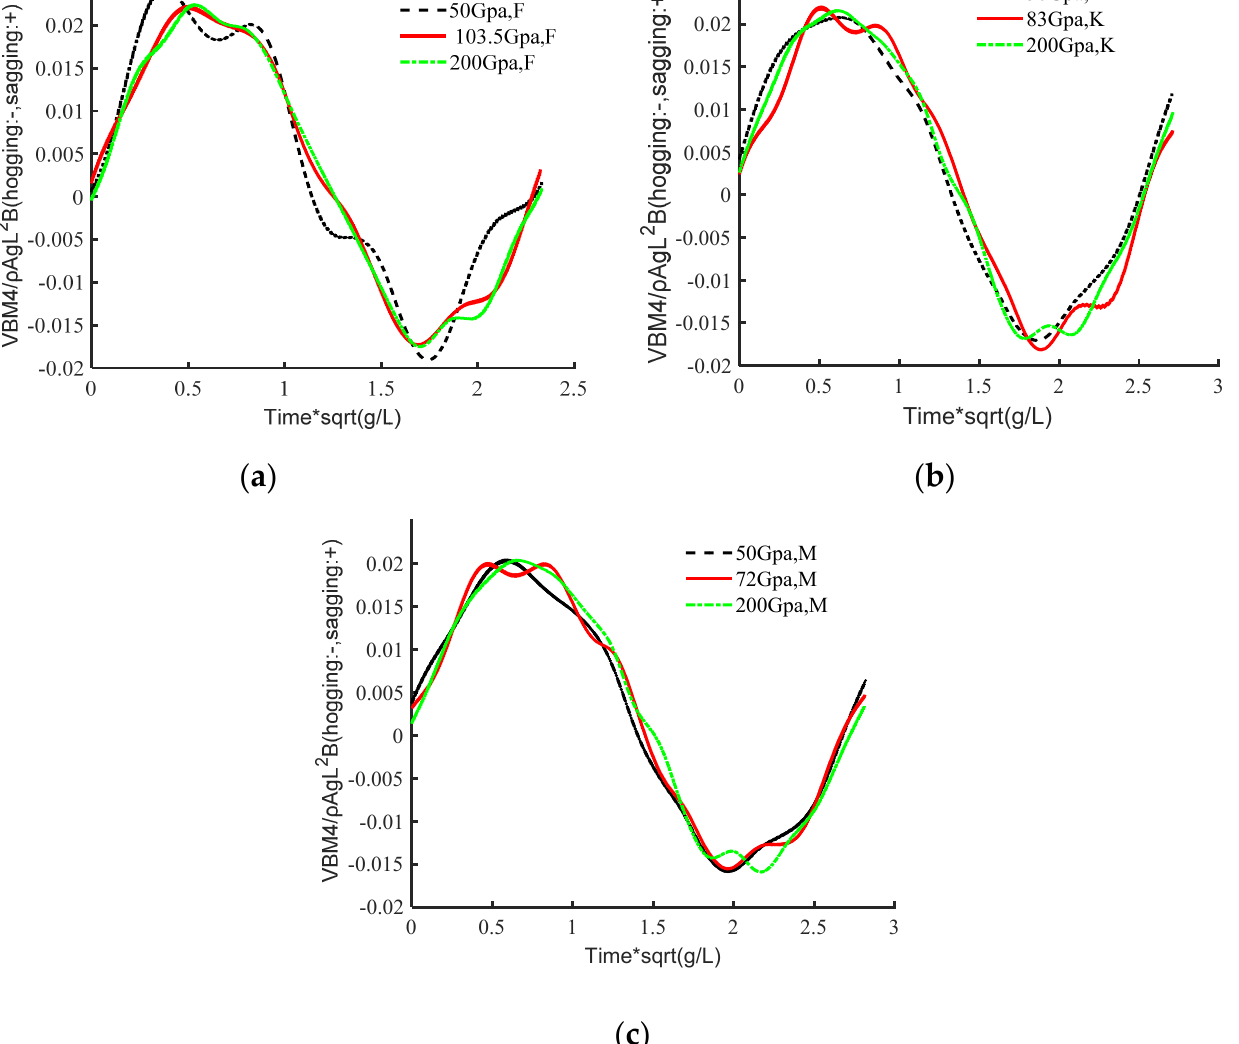
Figure 8. Non-dimensional vertical bending moment response of midship section with different λ /L. ( a ) λ /L = 0.857; ( b ) λ /L = 1.070; ( c ) λ /L = 1.228.